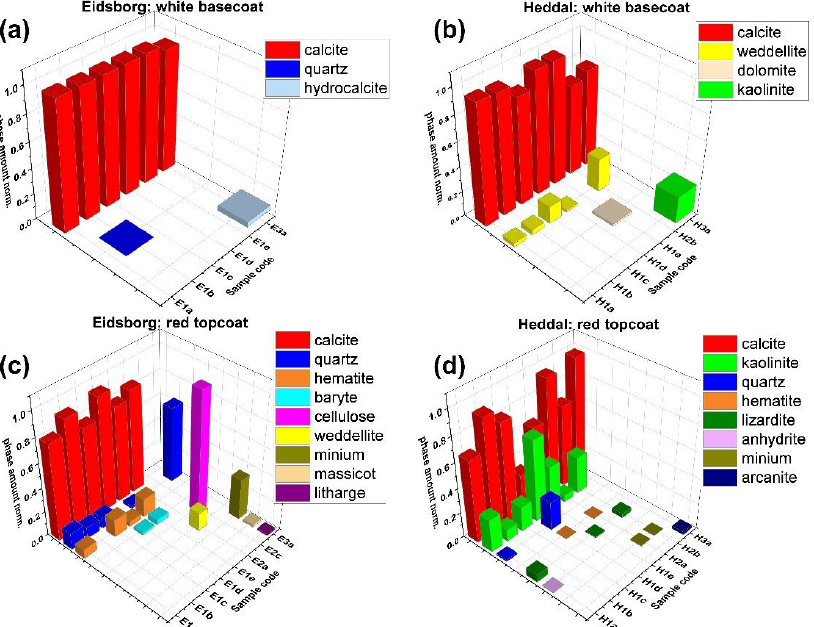
Figure 6. Semi-quantitative phase amounts of specimen from Heddal and Eidsborg by X-ray diffraction (XRD). ( a ) White basecoats in Eidsborg; ( b ) White basecoats in Heddal; ( c ) Red topcoat in Eidsborg; ( d ) Red topcoat in Heddal.